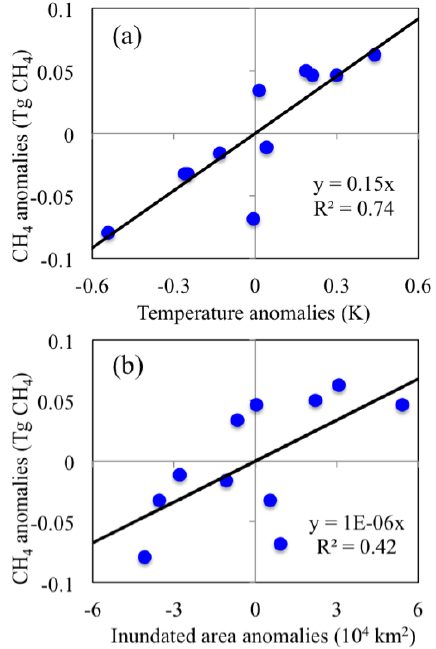
Figure 8. The correlation between CLM-predicted annual CH 4 emission anomalies and mean annual temperature anomalies (a) and correlation between annual CH 4 emission anomalies and predicted inundated area anomalies during 2000–2010. The anomalies are calculated by subtracting the average between 2000 and